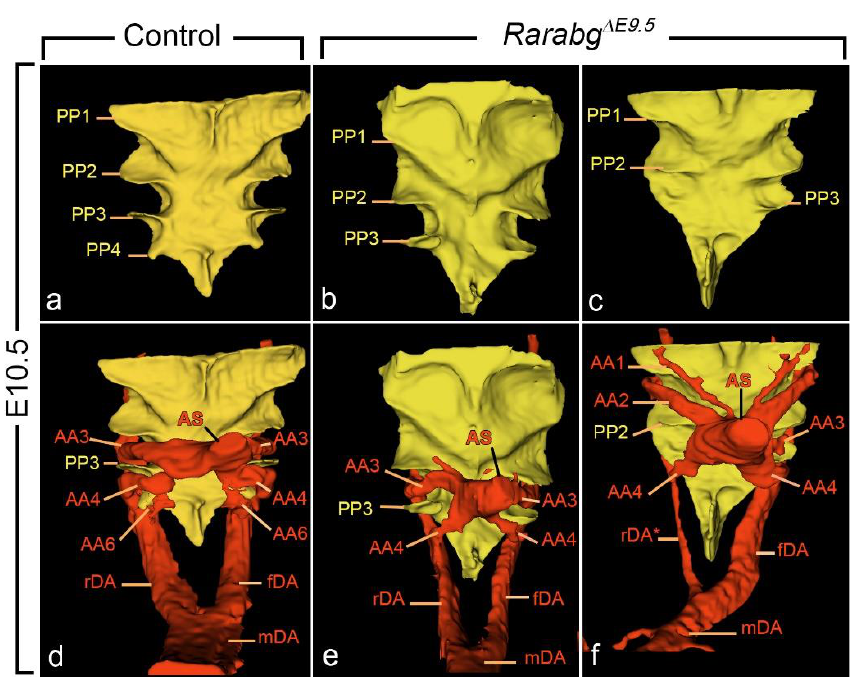
Figure 4. Ventral views of 3D-reconstructions of the pharyngeal cavity ( a – f ) and aortic arches ( d – f ) in a control embryo ( a , d ) and in Rarabg ΔE9.5 mutants ( b , c , e , f ) at E10.5. AA1, AA2, AA3, AA4, and AA6, 1st, 2nd, 3rd, 4th, and 6th aortic arches; AS, aortic sac; rDA, fDA and mDA, right, left and midline dorsal aortas, respectively; rDA*, hypoplastic right dorsal aorta; PP1, PP2, PP3, and PP4, 1st, 2nd, 3rd, and 4th pharyngeal pouches. Same magnifications in ( a – f ).